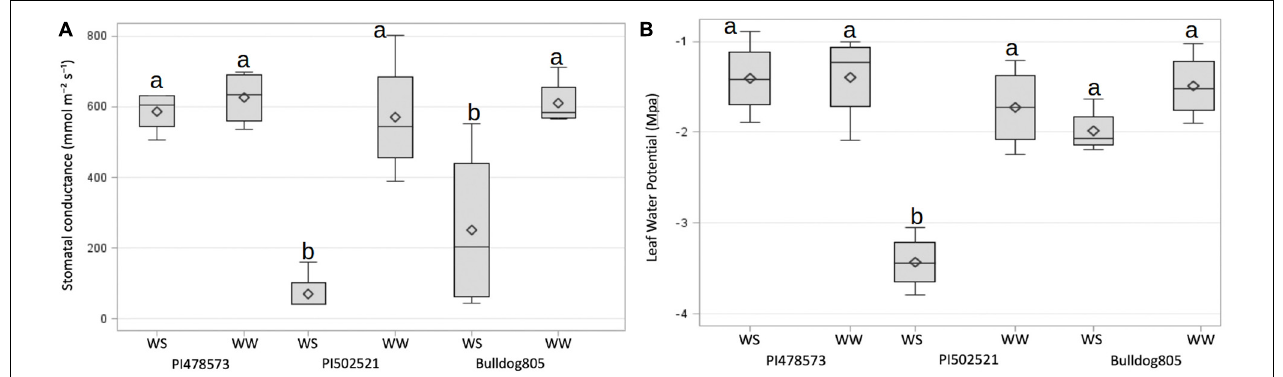
FIGURE 1 | Stomatal conductance (A) and leaf water potential (B) of plants grown in well-watered (WW) and water-stressed (WS) conditions of Exp. 1. The significance was based on LSD ( α =0.05) value for the treatment level. The horizontal line and symbol in the box interior represents the group median and mean phenotypic values with the low and higher Quartile represent as whiskers below and above bar graphs.